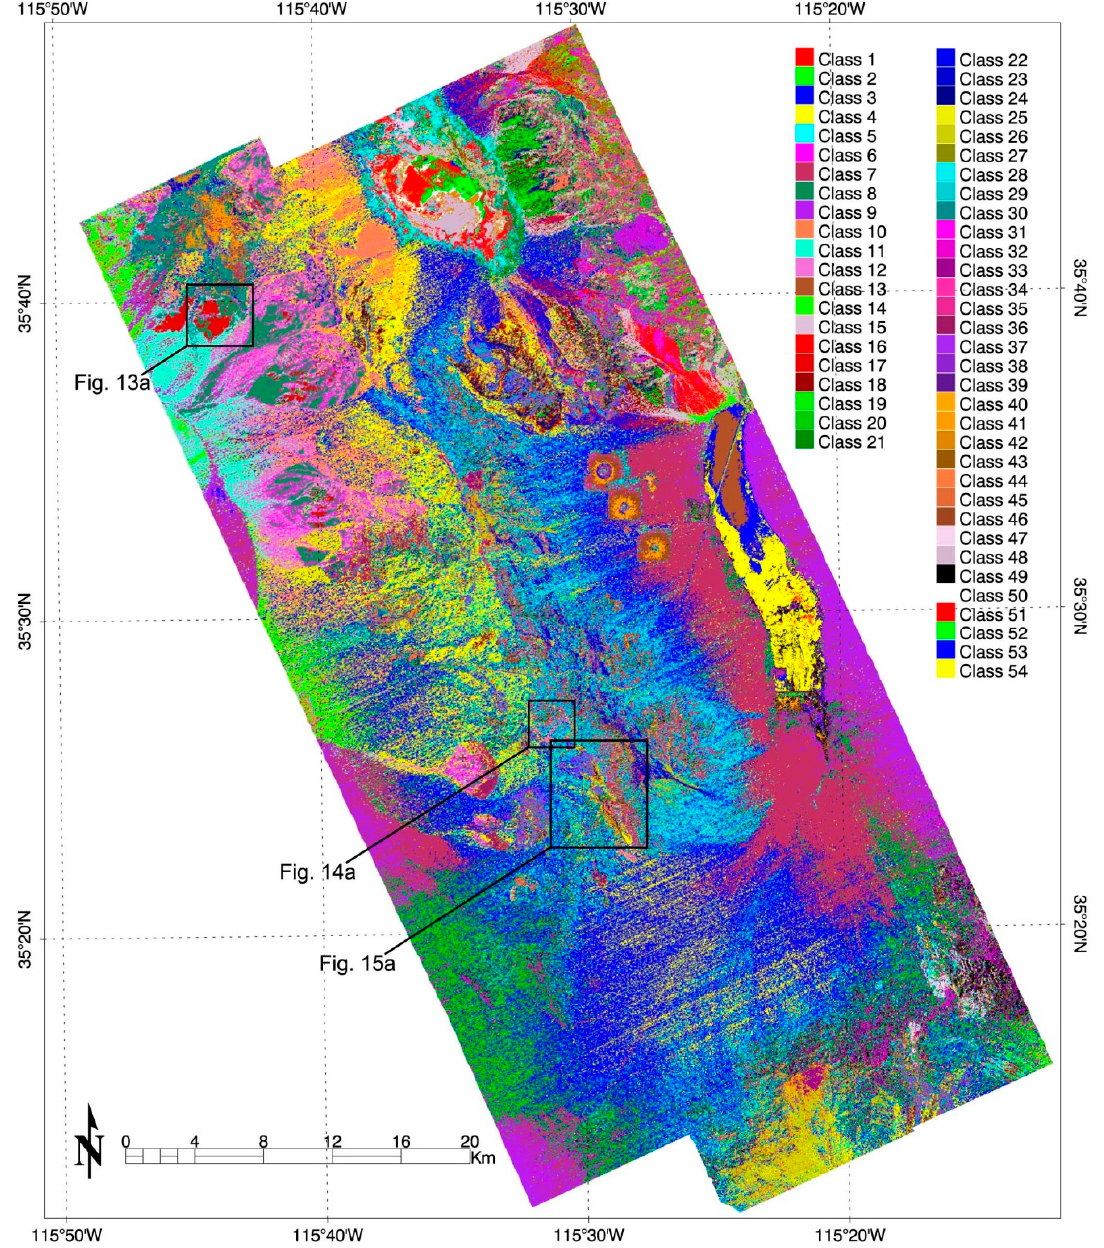
Figure 11. Classification map produced from integration of the visible to near infrared (VNIR), shortwave infrared (SWIR), and longwave infrared (LWIR) image endmembers. The map subsets shown in subsequent figures re outlined in black.